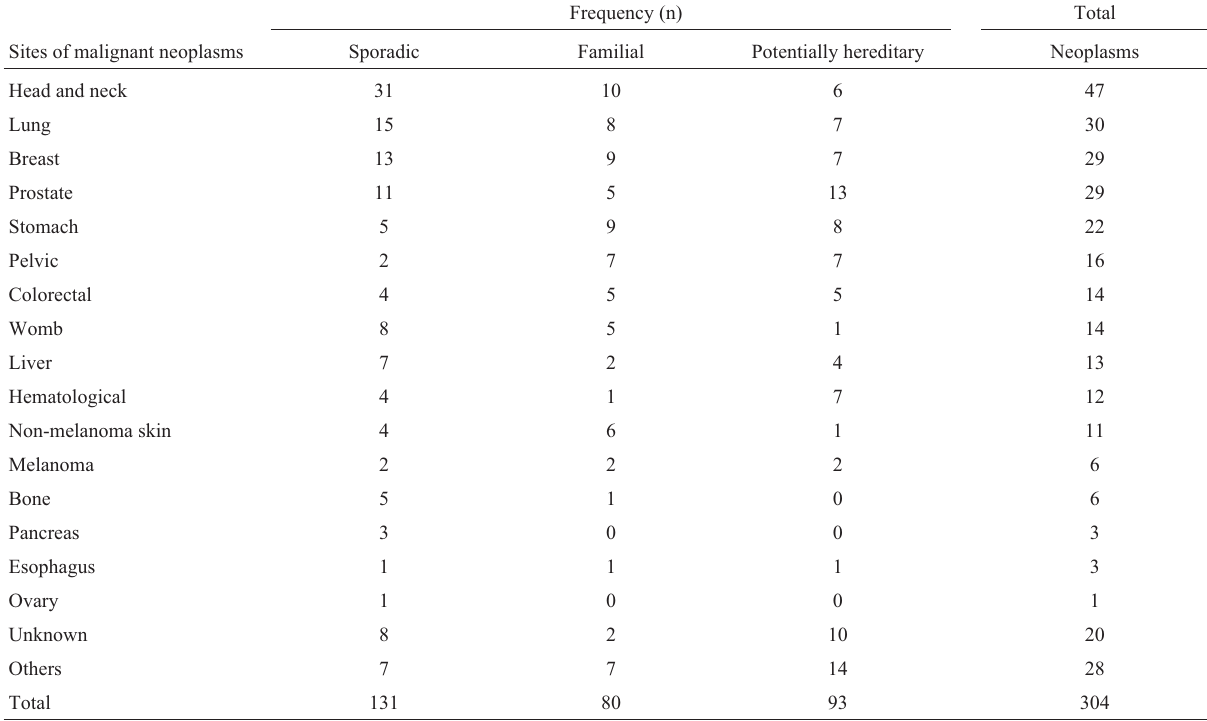
Table 3 - Distribution of malignant neoplasms according to the casuistry of cancer in the affected